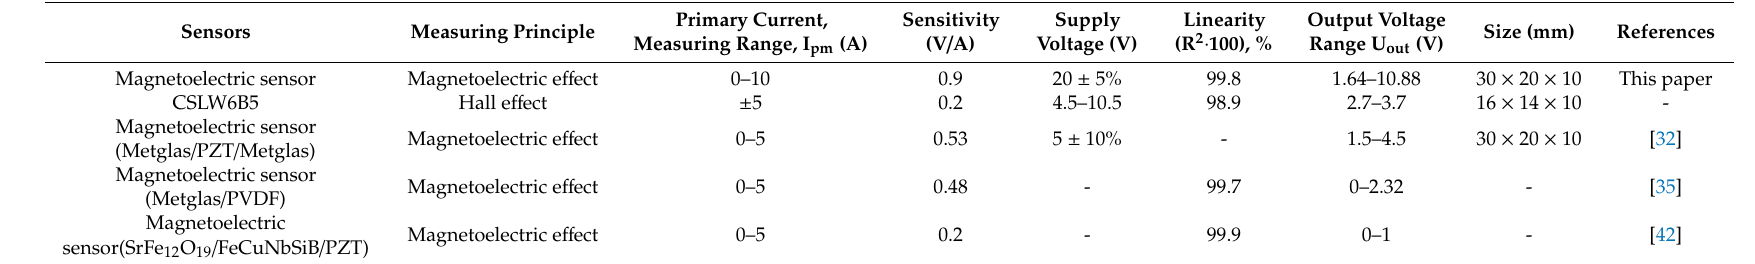
Table 2. Comparative of characteristics of current